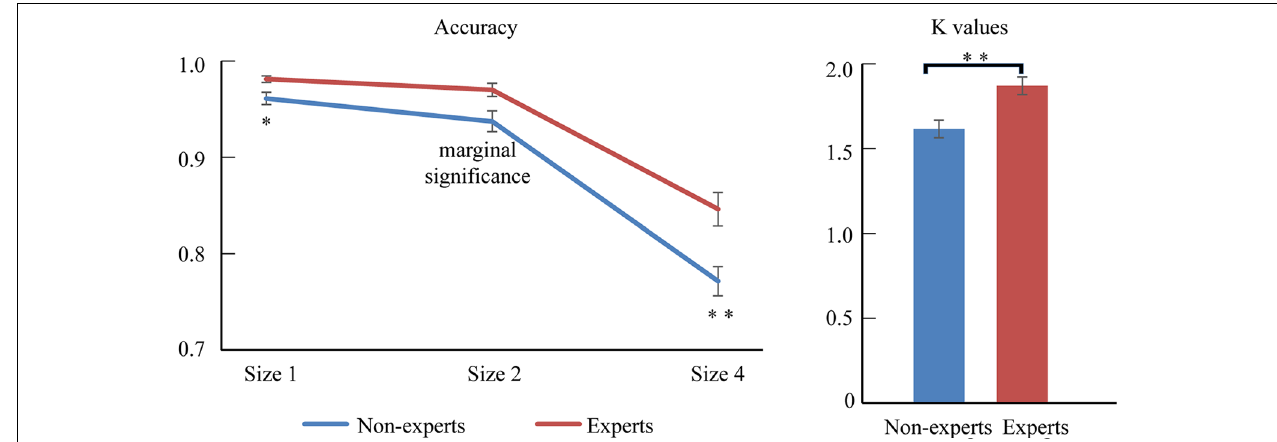
FIGURE 2 | The difference between experts and non-experts in accuracy and k -values. Error bars represent mean ± SEM in the left, after correction by Bonferroni method. ∗ p < 0.017, ∗∗ p < 0.003; in the right, ∗∗ p < 0.01.